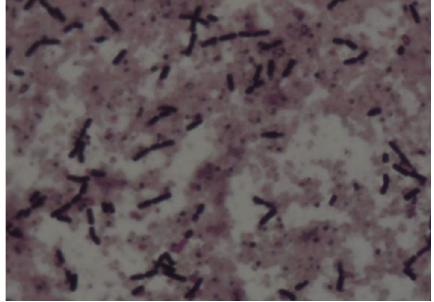
Figure 1: Gram staining and microscopic examination of Bacillus amyloliquefaciens.